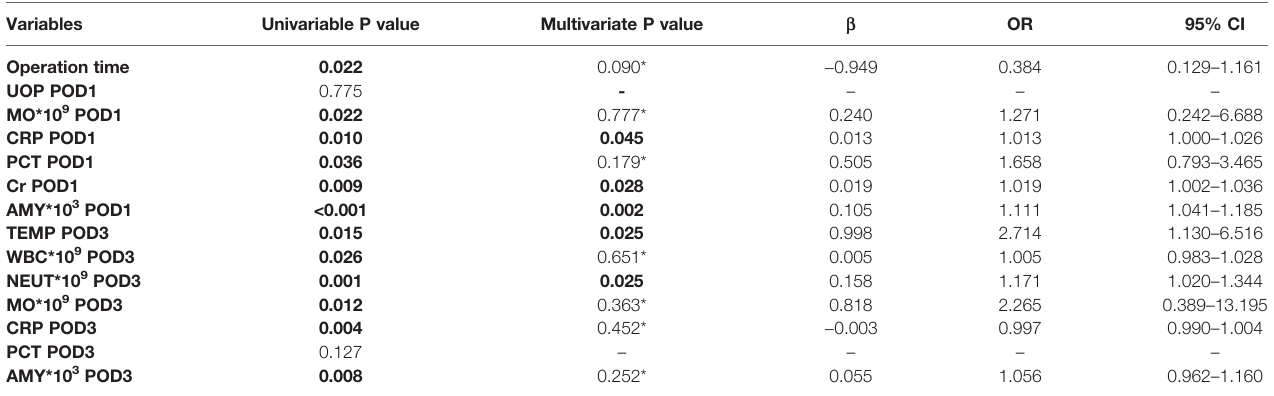
TABLE 2 | Univariate and multivariate logistic regression analysis for CR-POPF in patients following PD.